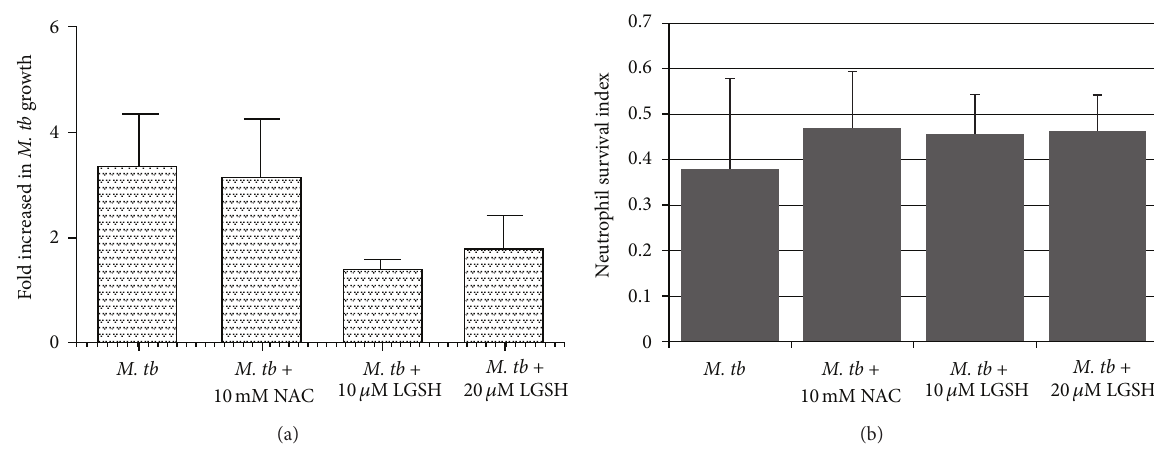
Figure 1: Intracellular survival of H37Rv in neutrophils treated with NAC and L-GSH ( 𝑛 = 5 ). Neutrophils were infected with processed H37Rv at a low dose multiplicity of infection of 1:10 (1 bacterium for every 10 neutrophils) and incubated for 2 hours to allow for phagocytosis. Unphagocytosed mycobacteria were removed by washing the infected neutrophils three times with warm sterile PBS. Infected neutrophils were cultured in RPMI + 5% AB serum at 37 ∘ C + 5% CO 2 in the presence and absence of NAC (10mM) or L-GSH (10 and 20 𝜇 M). Infected neutrophils were terminated at 1 hour and 24 hours after infection to determine the intracellular survival of H37Rv. Graph shows mean ± standard error.(a): Represents foldincrease in intracellular growth of H37Rv in neutrophils treated with NAC and L-GSH. (b): Determination of neutrophil viability following infection with H37Rv and treatment with NAC and L-GSH by quantifying DAPI stained cells ( 𝑛 = 5 ).